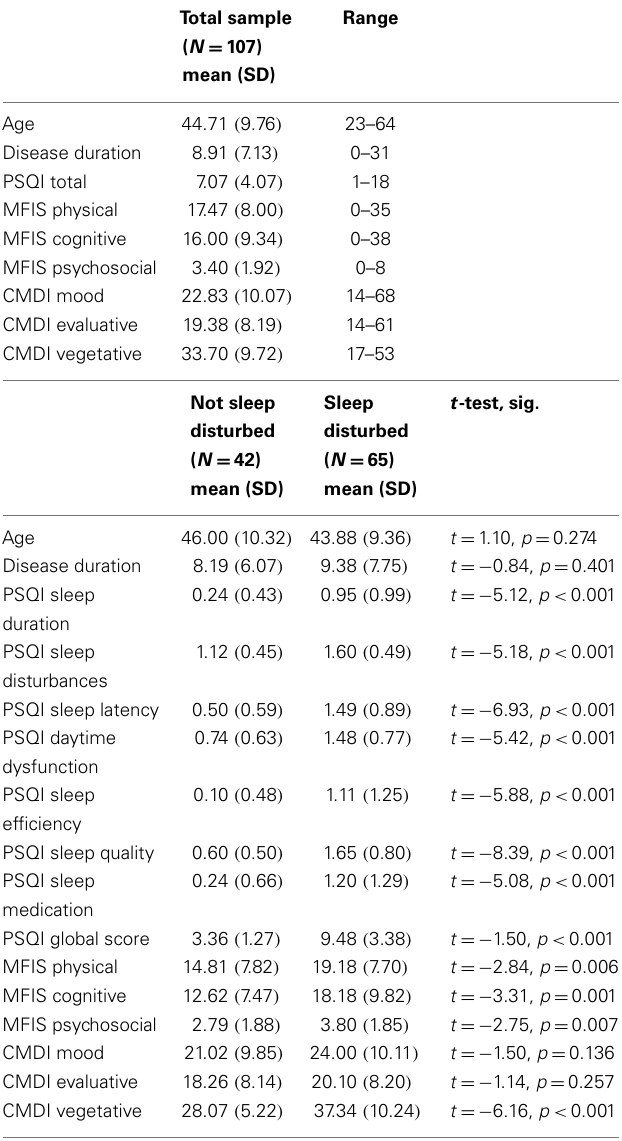
Table 2 | Participant demographics and group comparisons on disease variables, sleep, fatigue, depression